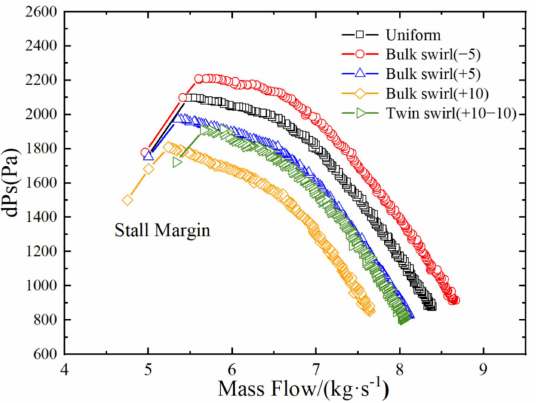
Figure 7. Static pressure rise curve with various inlet swirl distortion types under 100% design